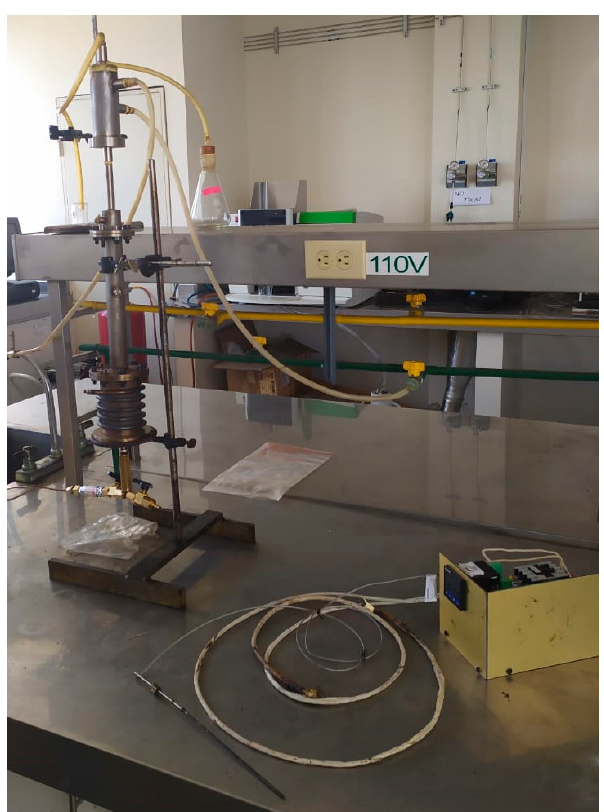
Figure 9. Microactivity test device.